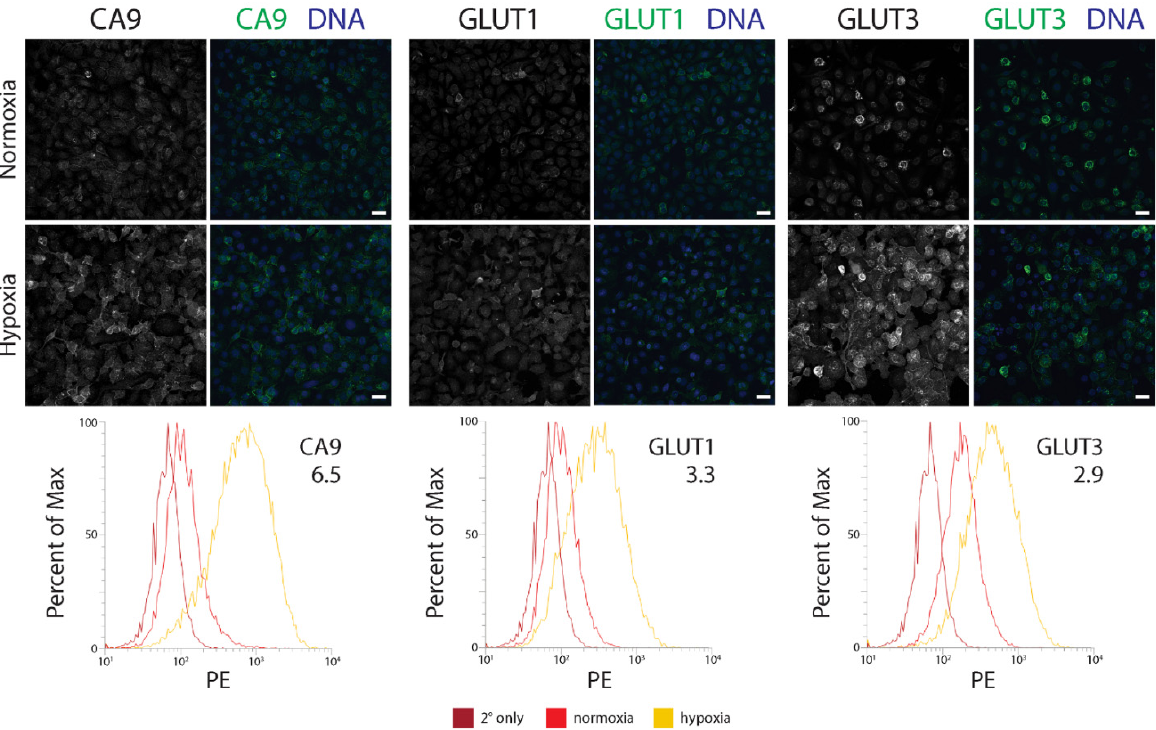
Figure 2. The GLUT3 protein is upregulated in hypoxic immortalized prostate epithelial cells. ( Upper and Middle panels) RWPE1 cells were cultured in either normoxic or under chronic hypoxic (1% O 2 ) conditions for 48 h and then processed for immunofluorescence microscopy. Cells were stained for either CA9, GLUT1, or GLUT3 (green, Upper and Middle panels). DNA, blue. Scale, 25 µ m. ( Lower panels) Comparison of flow cytometry profiles of CA9, GLUT1, or GLUT3 in cells cultured in normoxia (red) versus hypoxia (yellow). Cells stained with only secondary antibody is shown (dark red). The fold increase in level of the indicated proteins is denoted. PE,